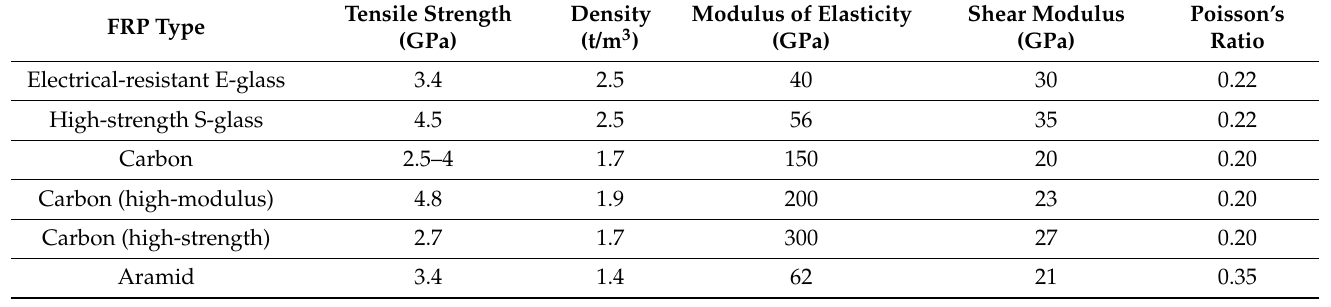
Figure 5. Comparison of design tensile strength and elasticity modulus of different types of fibers. Table 1. Physical and mechanical properties of different FRPs, adapted from Refs. [7,8].